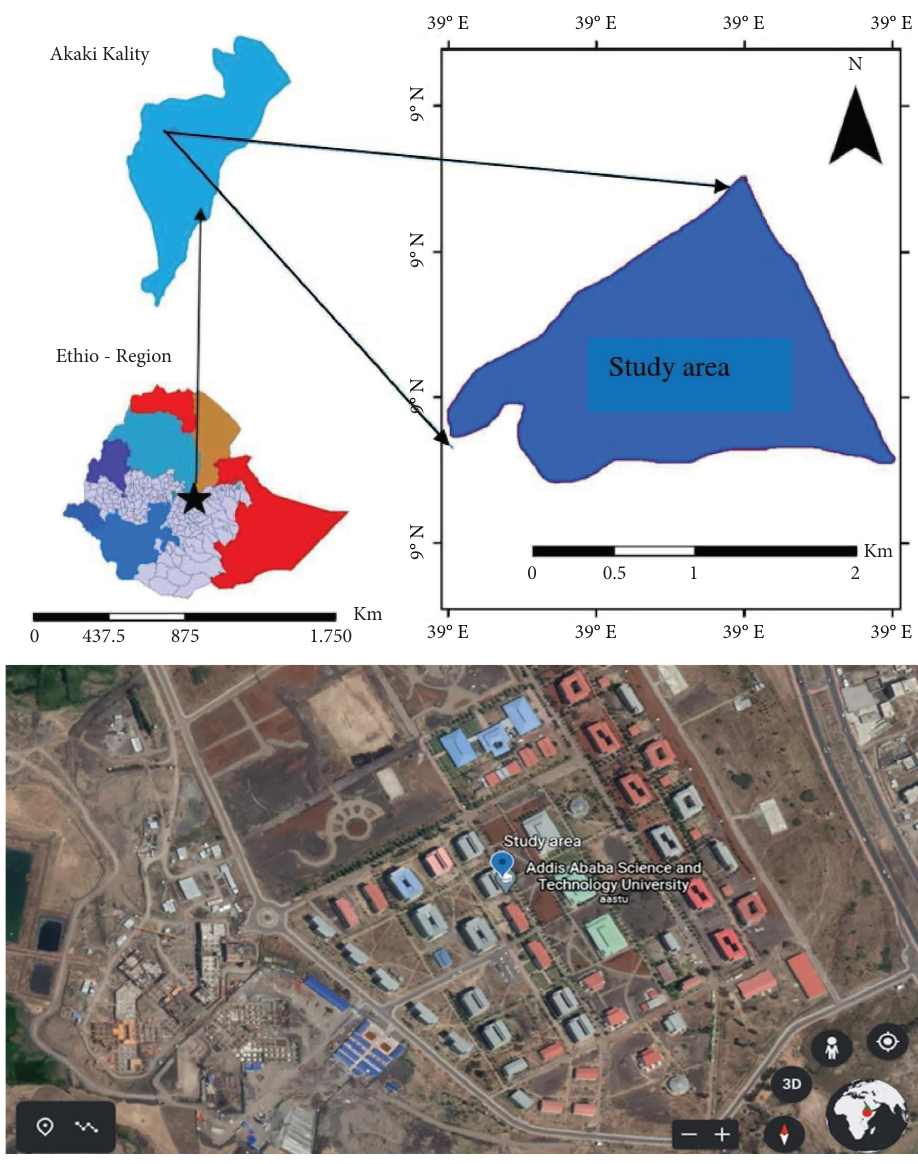
Figure 1: Study area